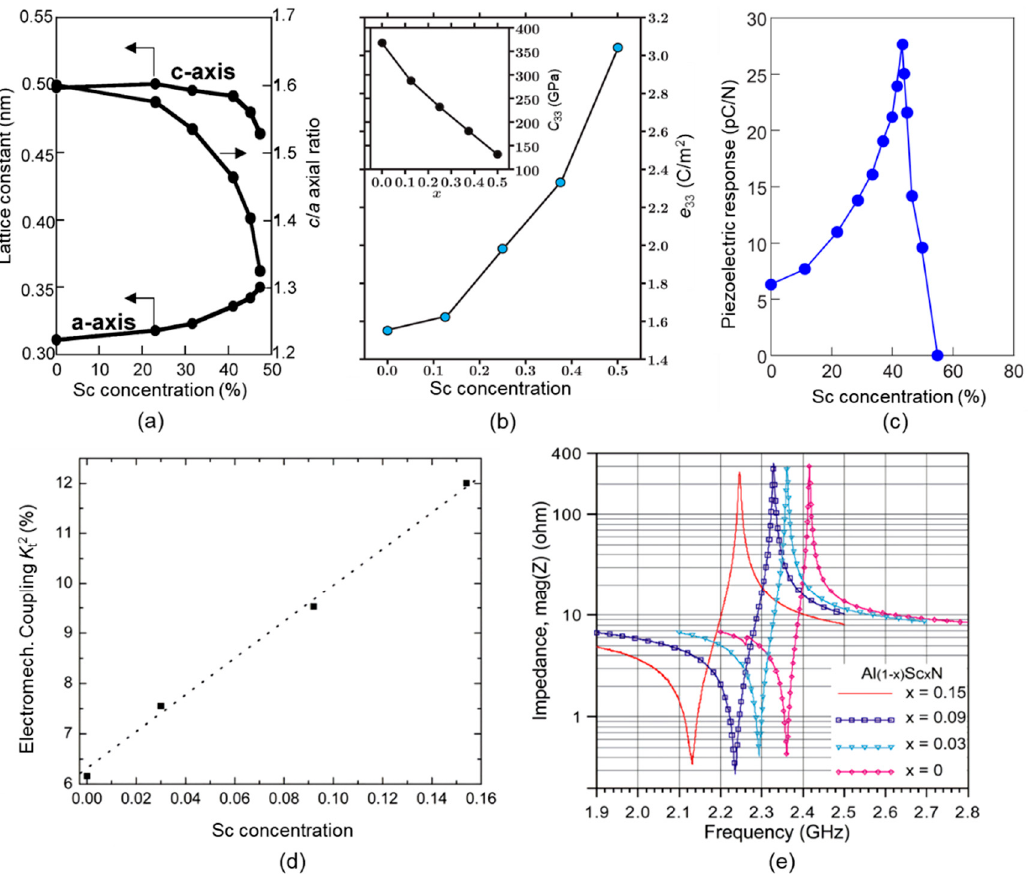
Figure 9. Effects of different Sc doping concentrations. ( a ) Lattice constant a , c , c / a value, reproduced with permission from [26]. ( b ) Piezoelectric constant e 33 and stiffness coefficient c 33 , reproduced with permission from [46]. ( c ) Piezoelectric strain coefficient d 33 , reproduced with permission from [45]. ( d ) Electromechanical coupling coefficient k t2 , reproduced with permission from [65]. ( e ) Measured FBAR impedance curve, reproduced with permission from [65].